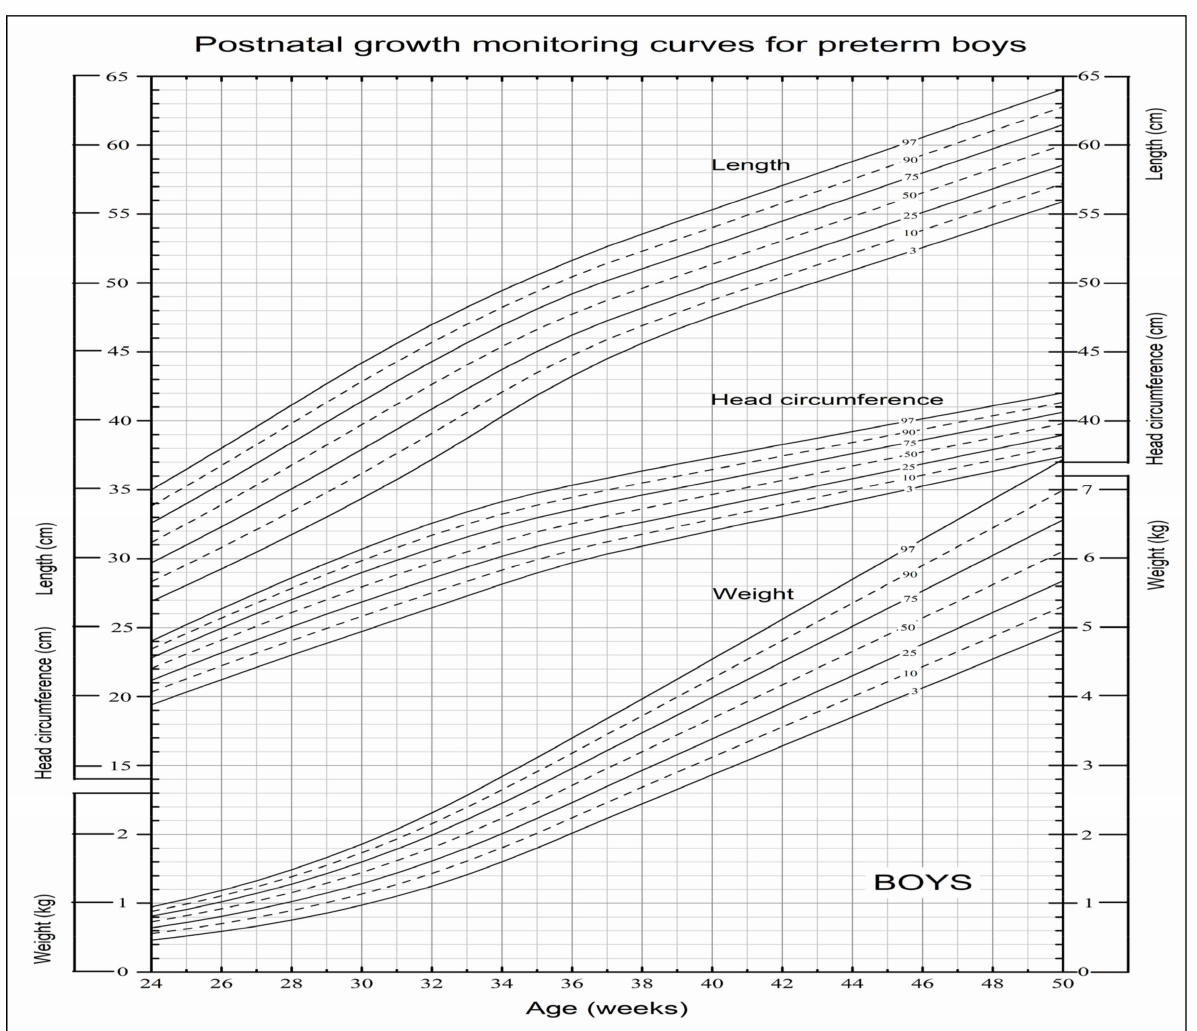
Figure 2. Postnatal growth monitoring charts for preterm boys in